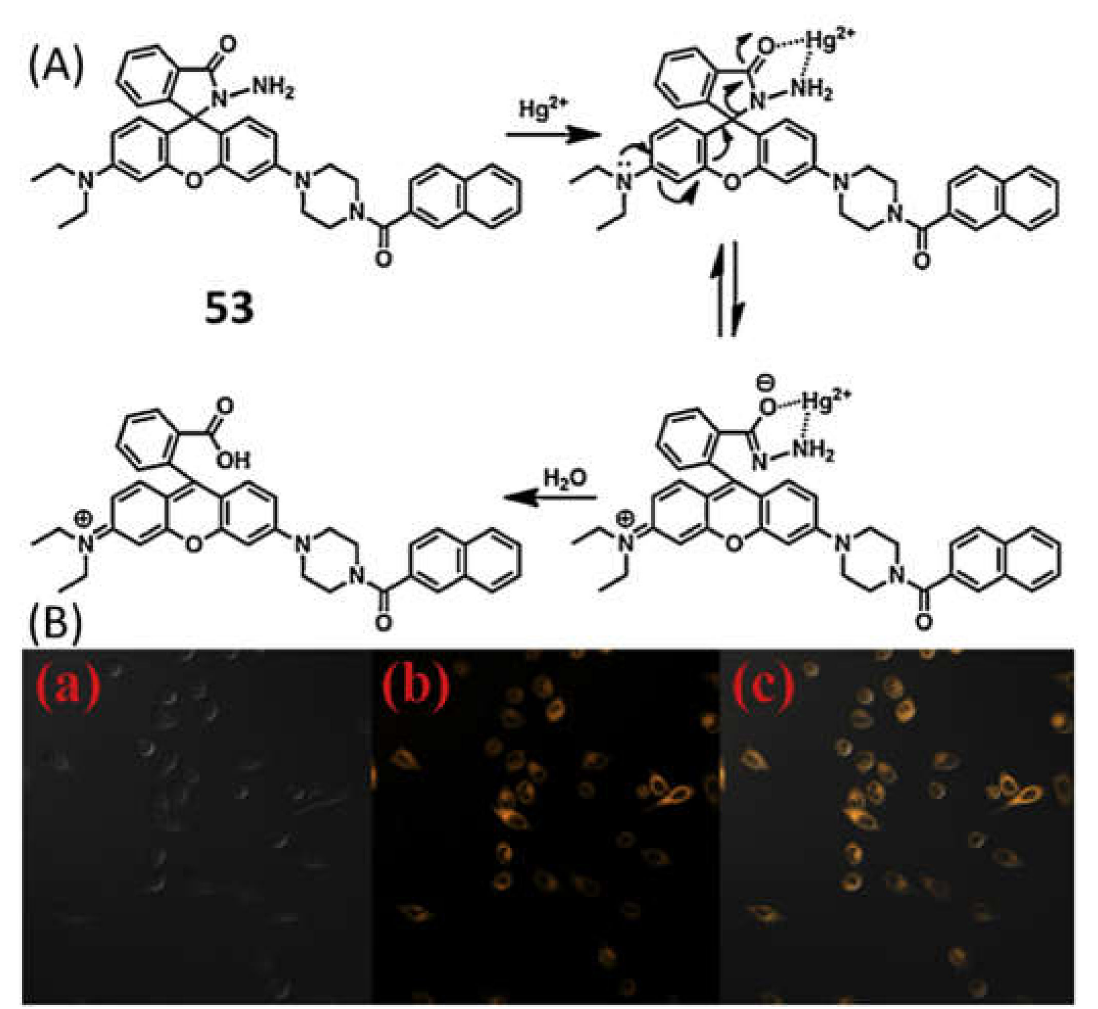
Figure 19. ( A ) Sensing mechanism of 53 for Hg 2+ . ( B ) Confocal fluorescence images of HeLa cells with an excitation filter of 488 nm. Probe 53 loaded HeLa cells: ( a ) Bright field image; ( b ) Dark field image; ( c ) Merged images of a and b . Reproduced with permission from [82]. Copyright 2020